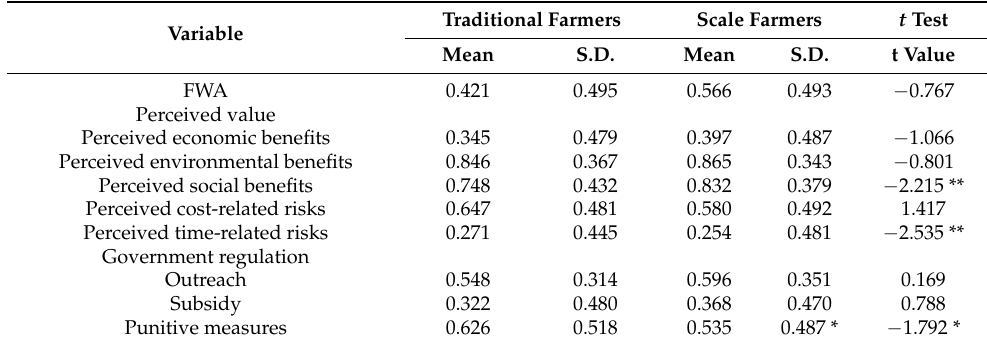
Table 5. Descriptive statistics of perceived value and government regulation for different scale farmers. Traditional Variable